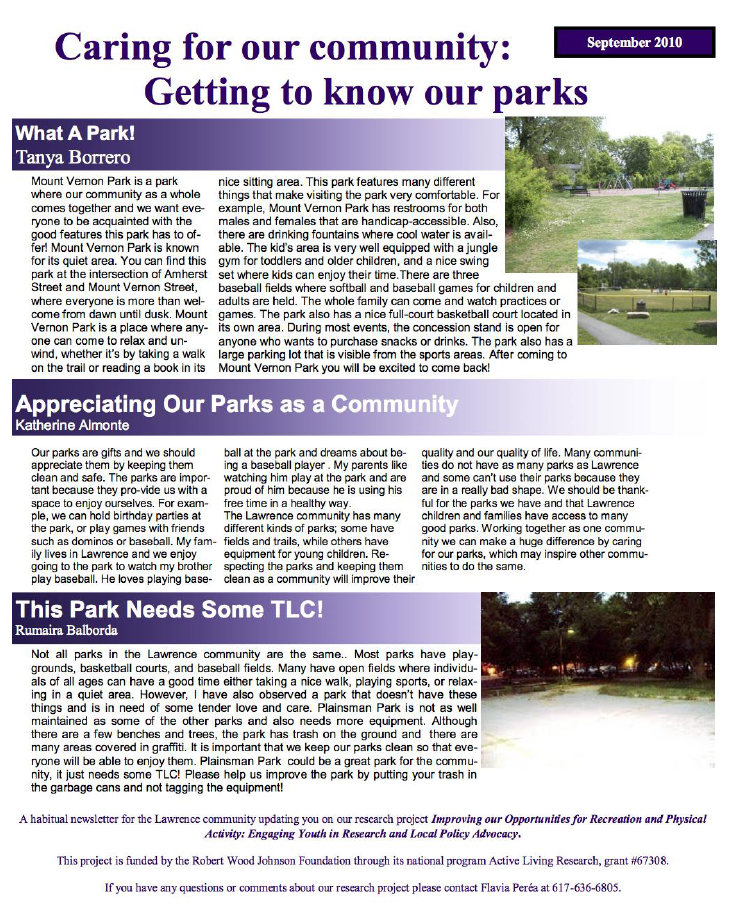
Figure 2. Newsletter: Caring for our Community.